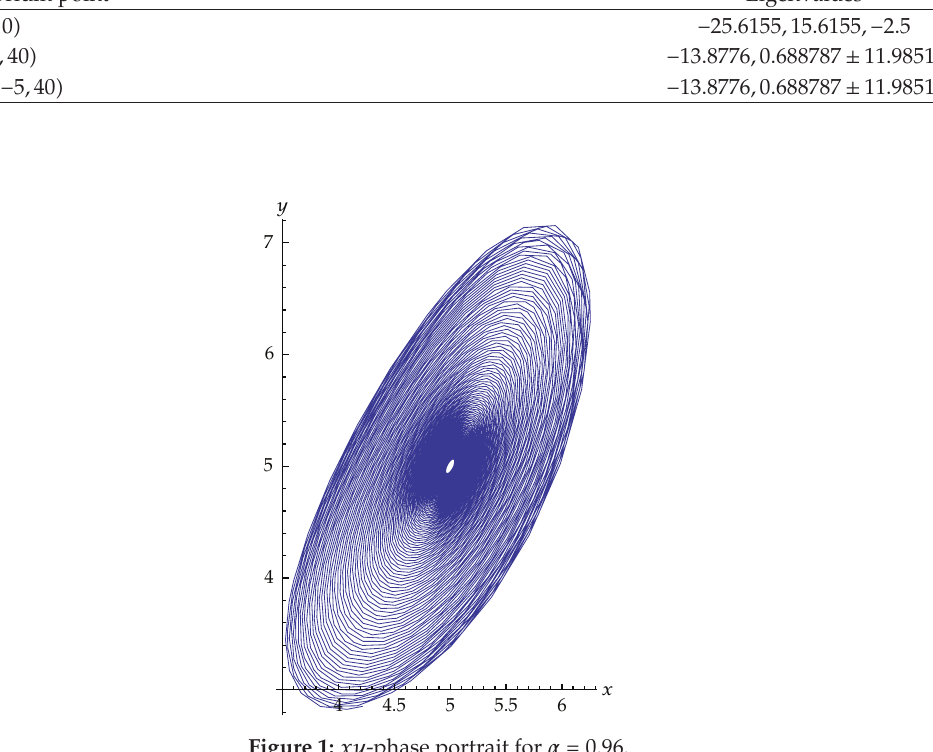
Figure 1: xy -phase portrait for α (cid:8) 0 .